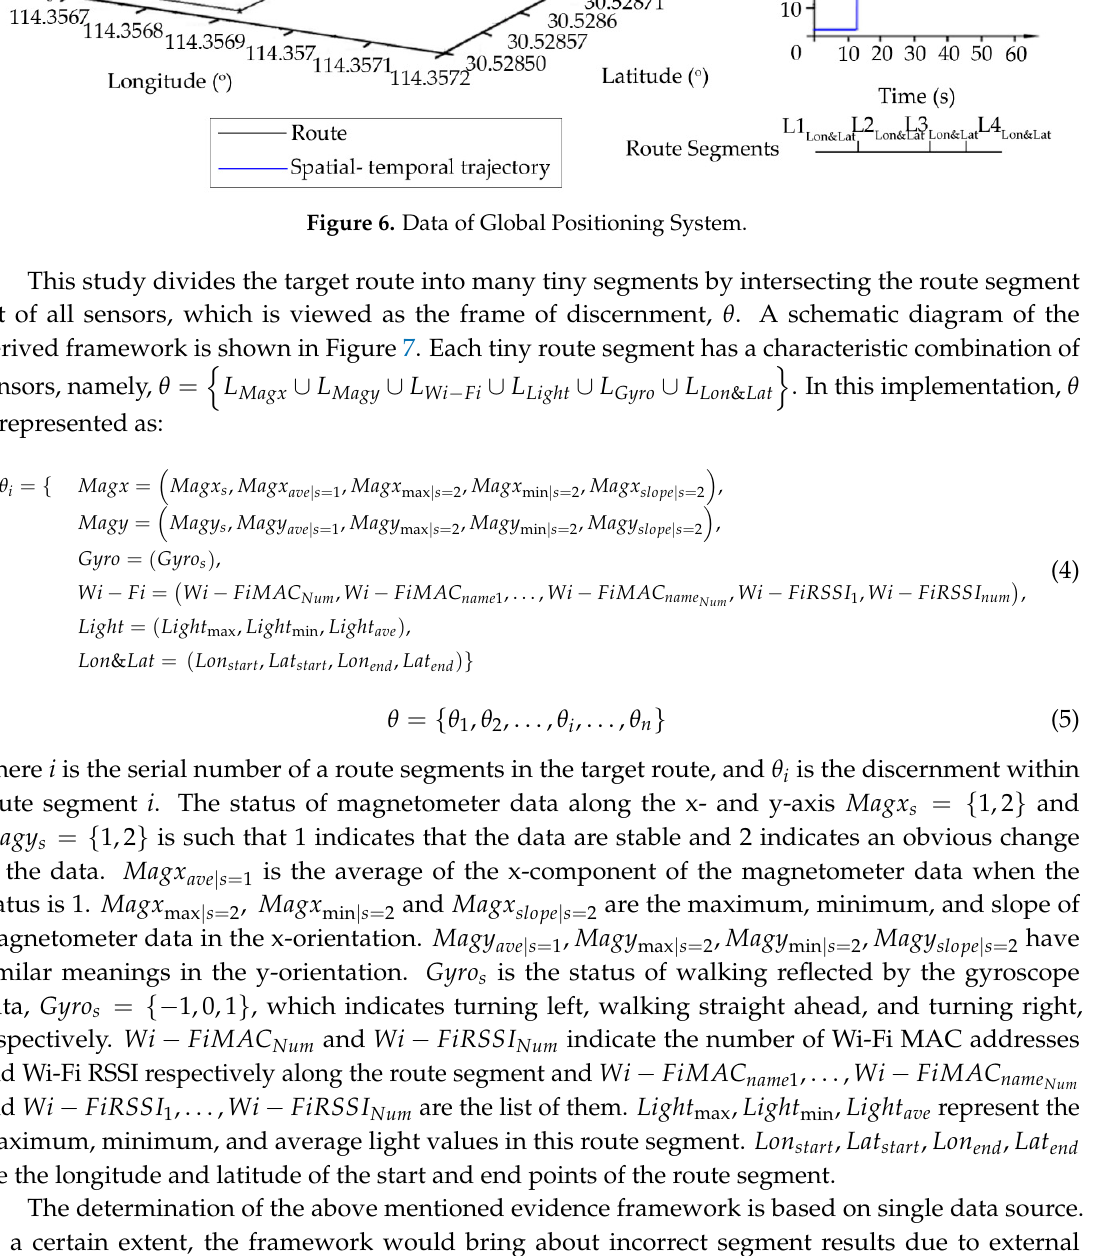
 , which indicates turning left, walking straight ahead, and turning right, respectively.